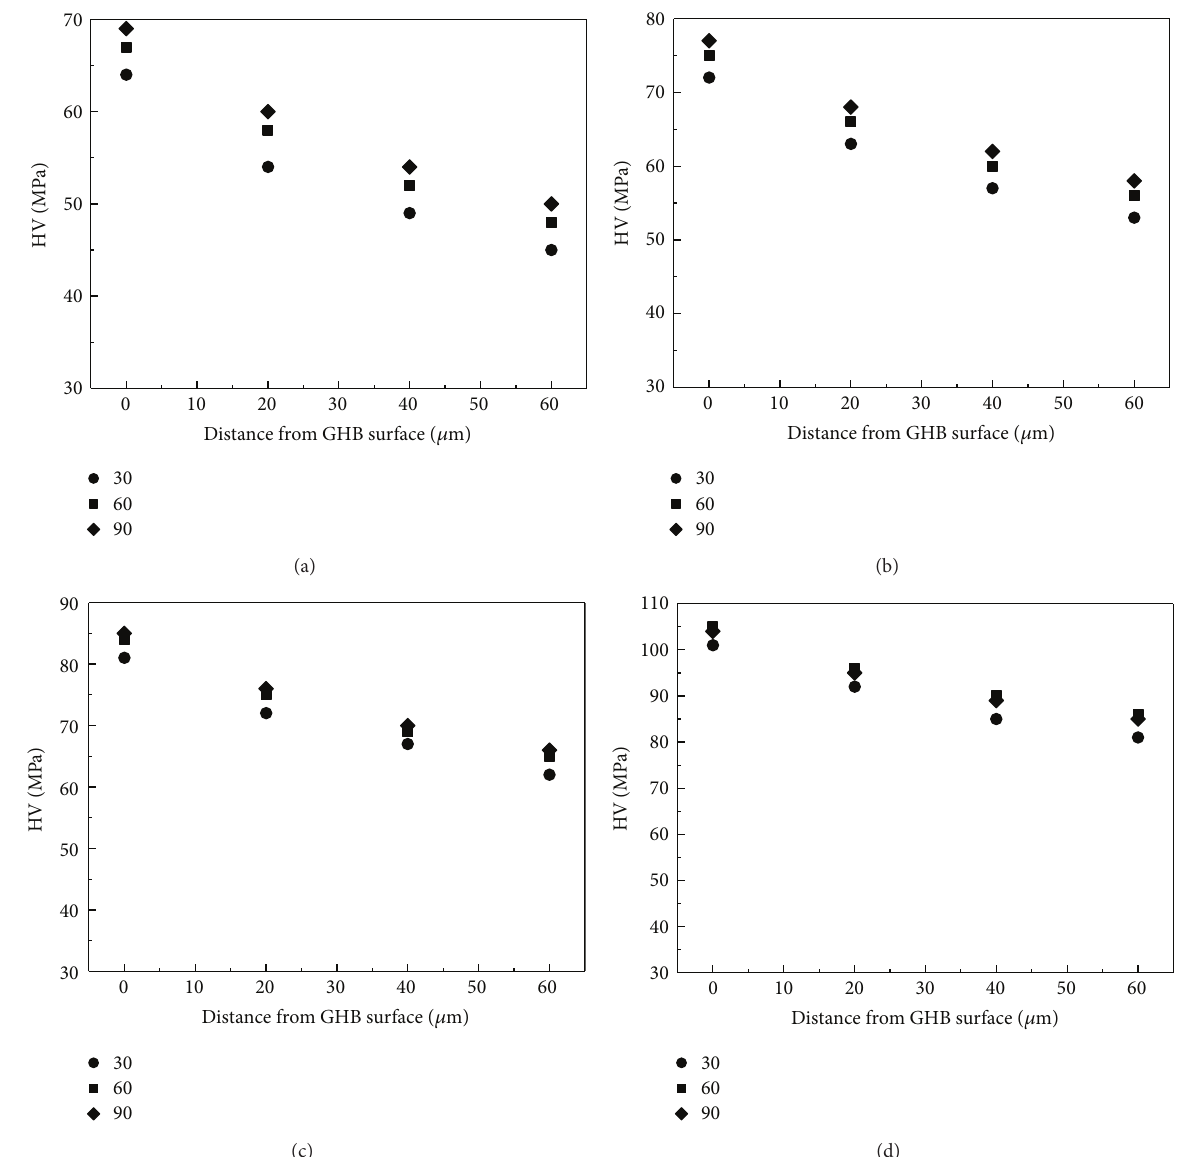
Figure 14: The influence of age of curing on the interfacial HV of cement paste at different levels of relative humidity ((a) for 7d, (b) for 14d, (c) for 28 d, and (d) for 56